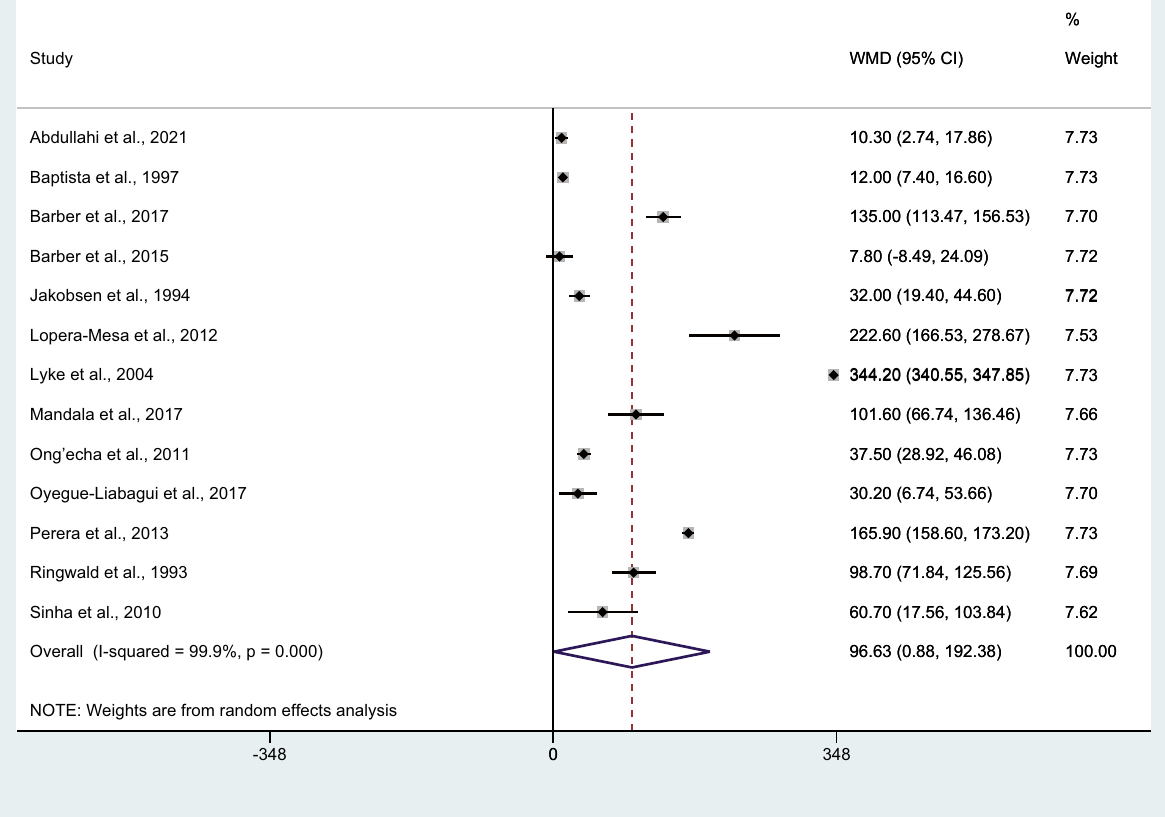
Figure 2. Differences in IL-6 levels between patients with severe malaria and non-severe malaria. Abbreviation: WMD, weighted mean difference; CI, confidence interval; black diamond symbol, point estimate; solid line in the middle of the graph at 0, zero effect size; Dashed red line: pooled WMD between the two groups; I 2 , level of heterogeneity; P = 0.00 or less than 0.05, significant